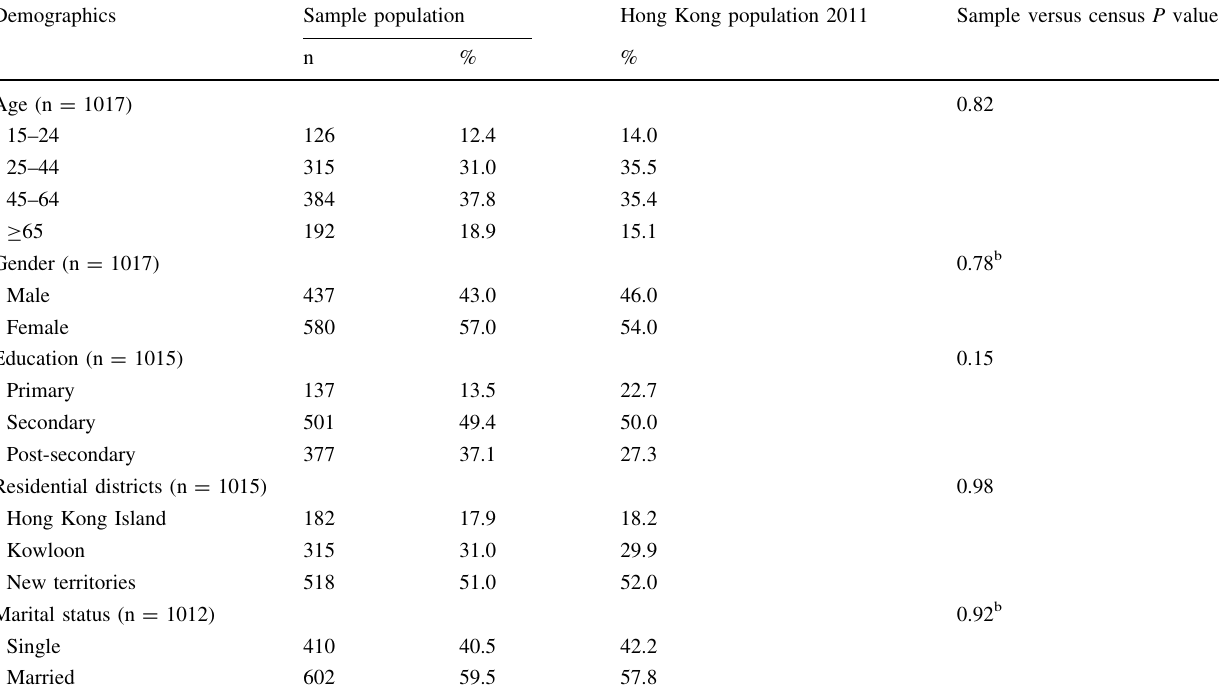
Table 1 Sociodemographic characteristics of the survey respondents in January/February 2016 and the general population in Hong Kong in 2011 (Hong Kong SAR Census and Statistics Department